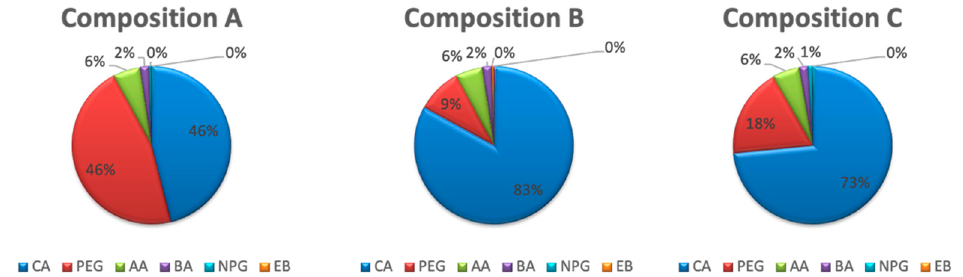
Figure 3. Chemical composition of the dry photopolymer layers (% w/w).